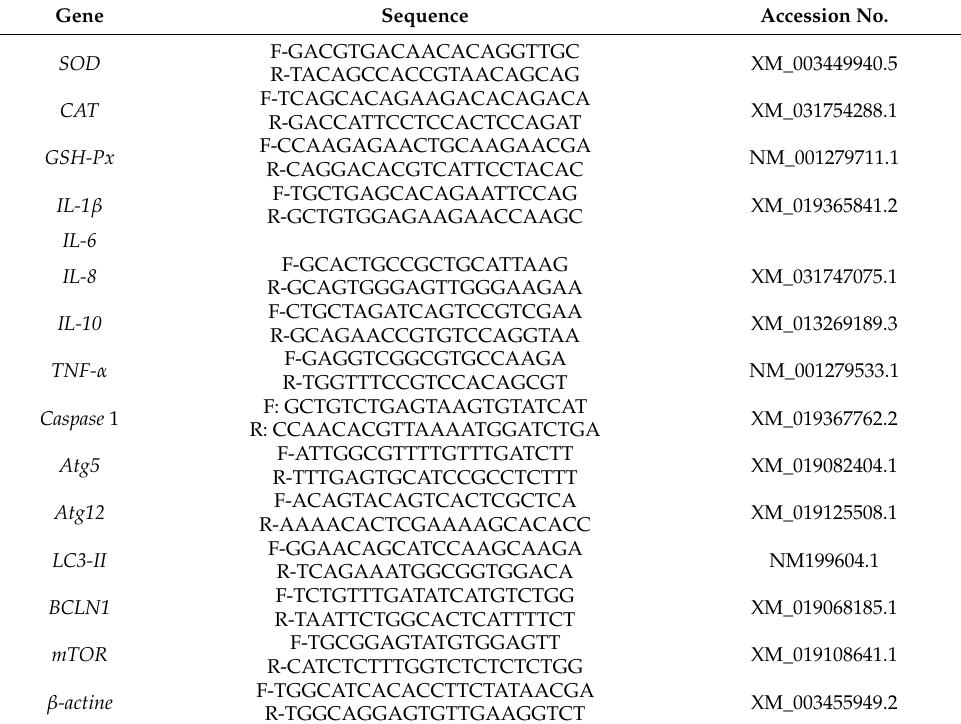
Table 3. Primers sequence employed for analysis of quantitative real-time